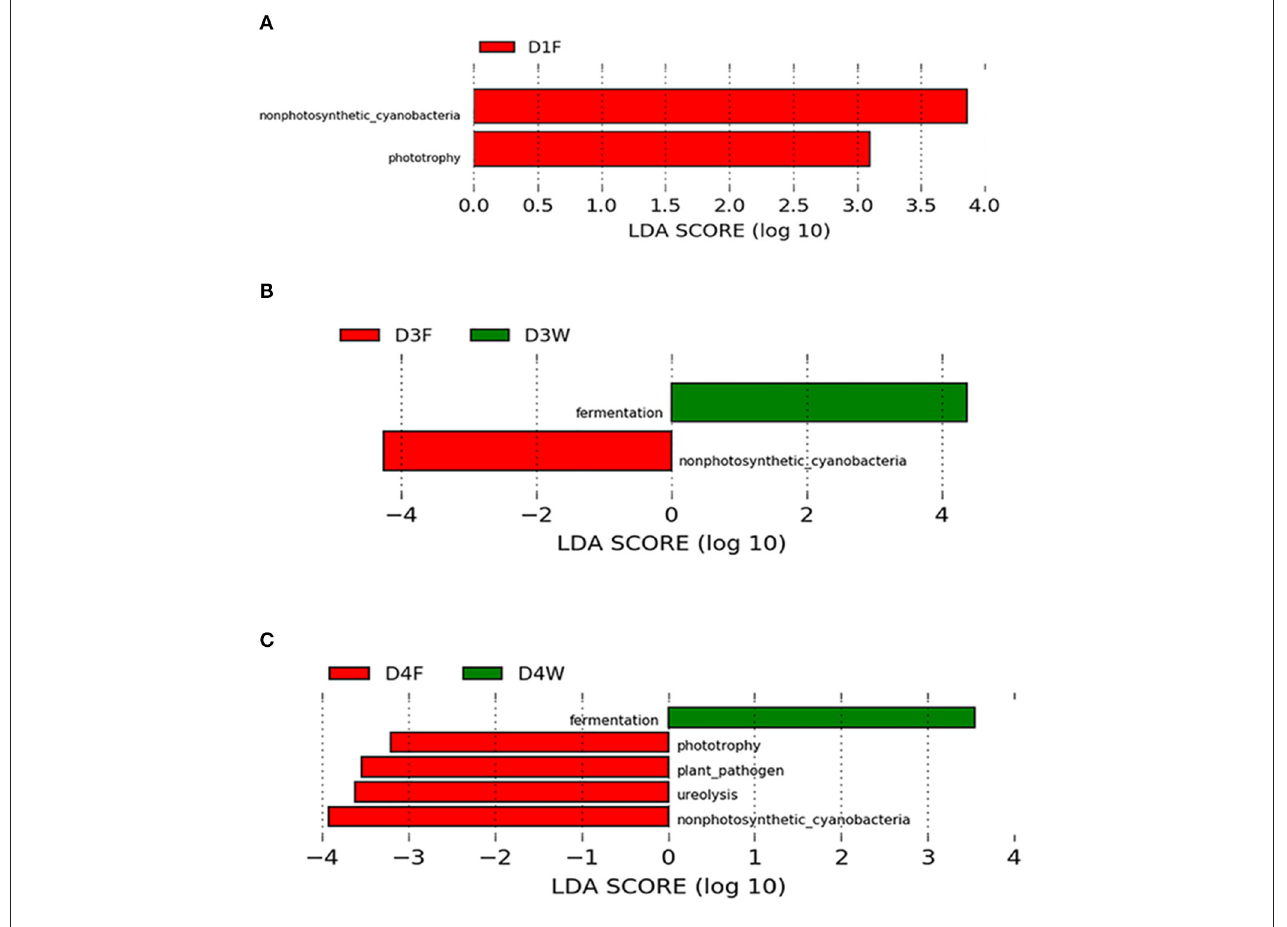
FIGURE 6 | LEfSe (LDA > 3.0, P < 0.05) showing the predicted functional groups significantly abundant in decay classes 1 (A) , 3 (B) , and 4 (C)